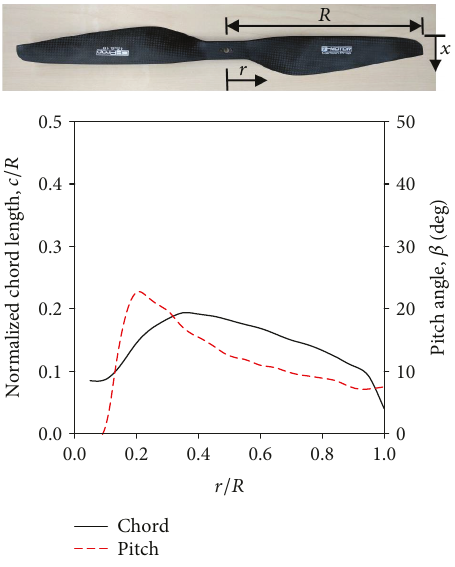
Figure 6: Geometry of T-motor